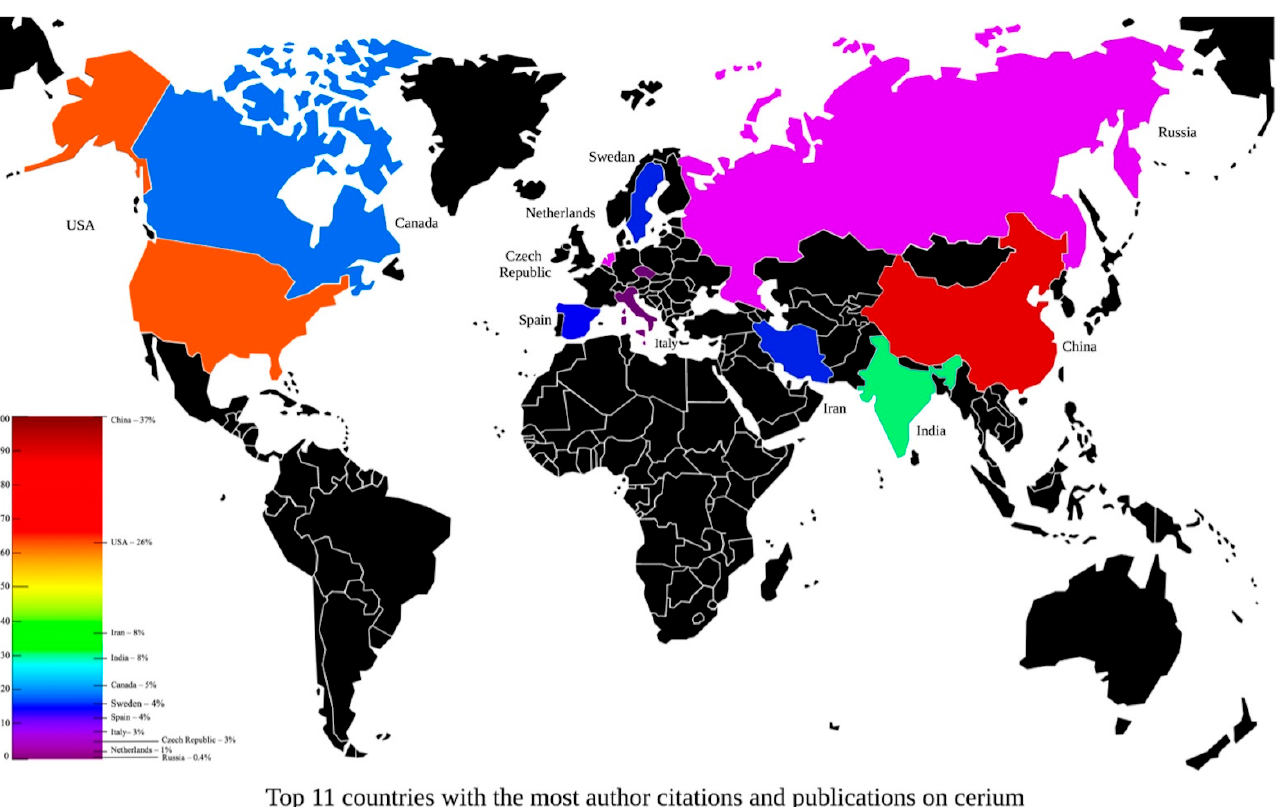
Figure 5. Top 11 countries, with the highest citations (minimum 10) and documents (minimum 10) per authors, grouped by country affiliations. Extrapolated from the dataset obtained from the WoS database, using the term “cerium oxide or ceria or nanoceria or nano ceria” in the years